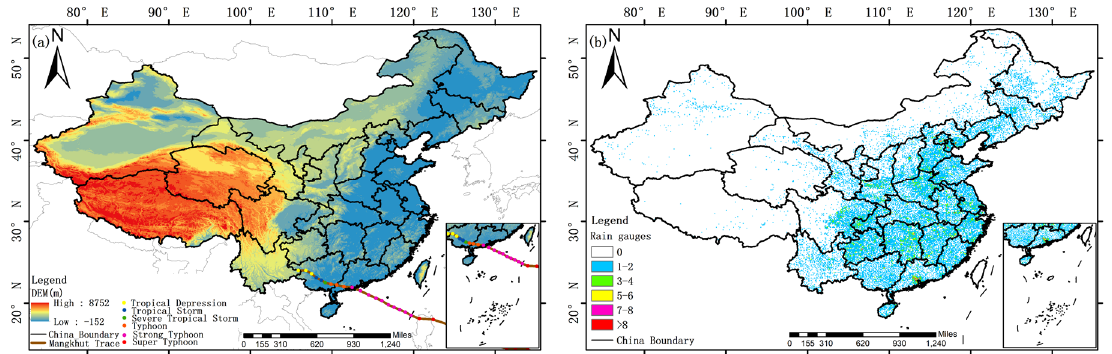
Figure 1. Terrain distribution over Mainland China and the tracks of typhoon Mangkhut ( a ) and the rain gauge distribution over Mainland China ( b ).